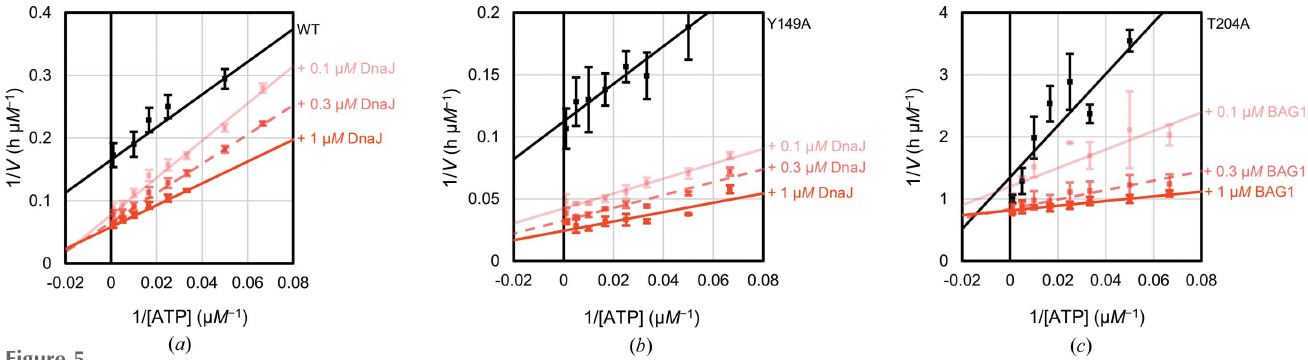
Figure 5 Lineweaver–Burk plots for the ATPase activities of ( a ) WT-Hsp72 in the presence of DnaJB1, ( b ) Y149A-Hsp72 in the presence of DnaJB1 and ( c ) T204A-Hsp72 in the presence of BAG1. Standard error bars and regression lines are drawn based on the mean of five independent